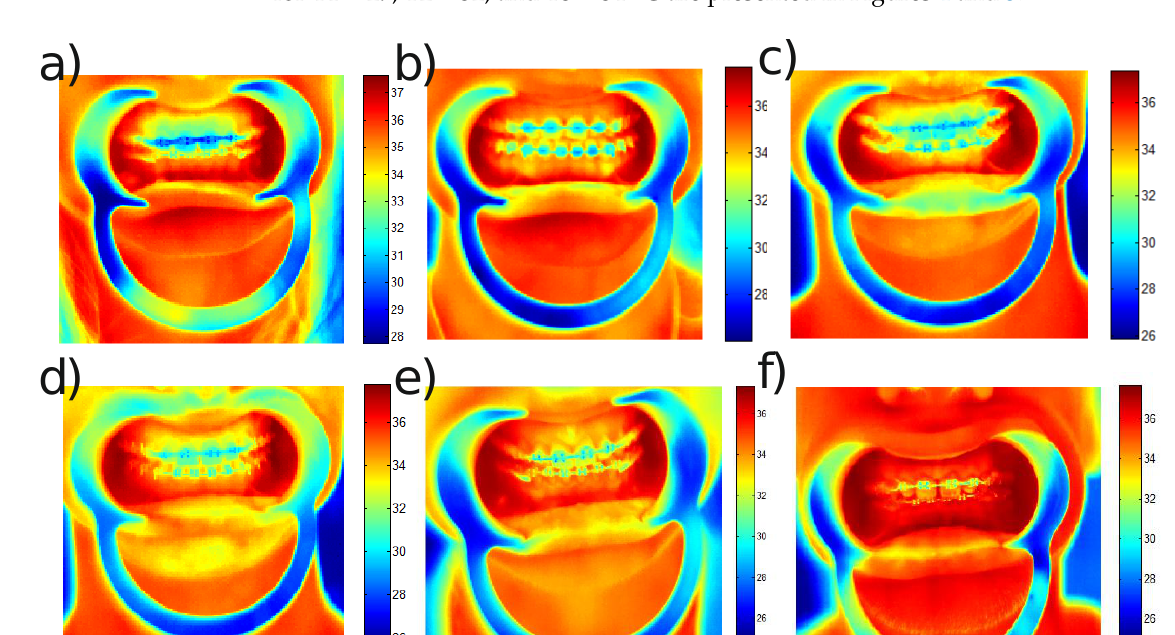
Figure 2. Sample, selected images from a sequence of images, before measurements for ( a ) patient No. 1; ( b ) patient No. 2; ( c ) patient No. 3; ( d ) patient No. 4; ( e ) patient No. 5; ( f ) patient No. 6.